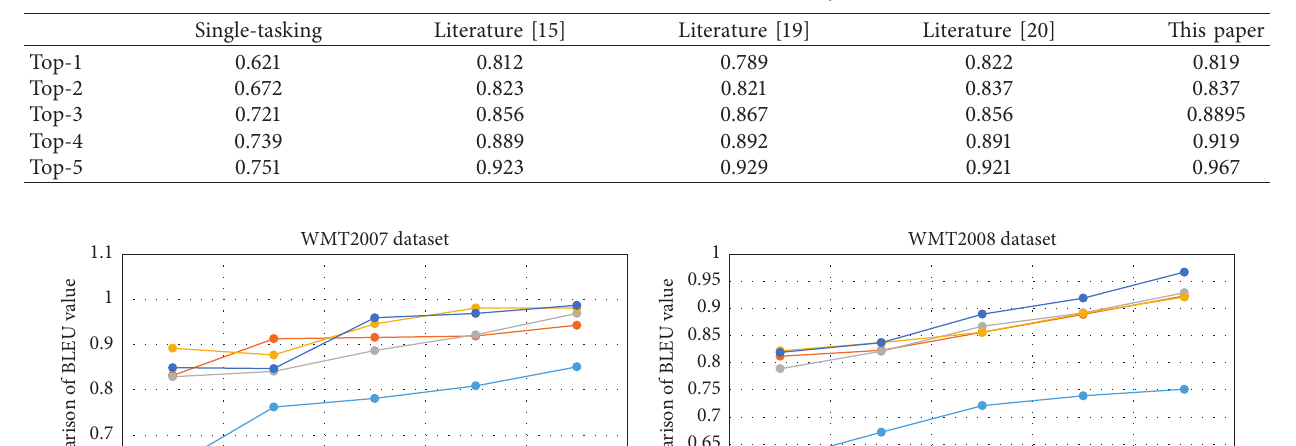
Table 2: Phrase-level translation accuracy.